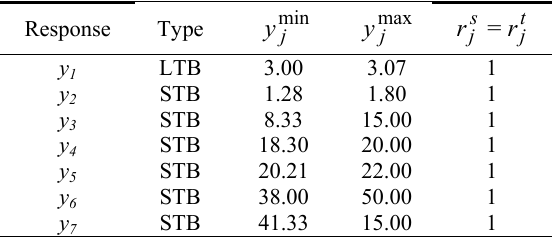
Table 13. Type of response and their specifications